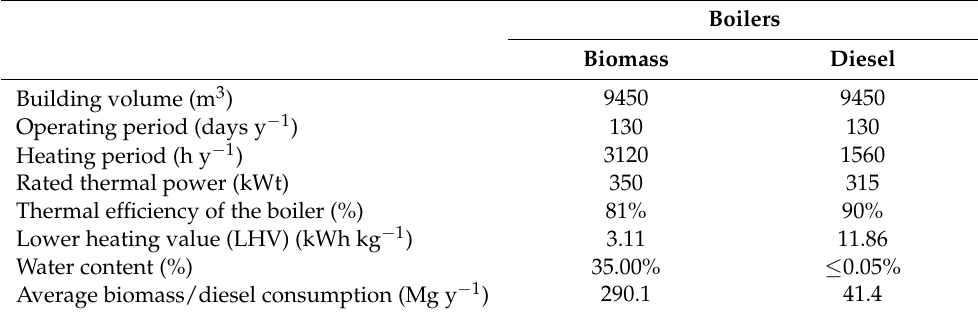
Table 1. Main parameters considered to evaluate the annual biomass or diesel consumption in the two boilers